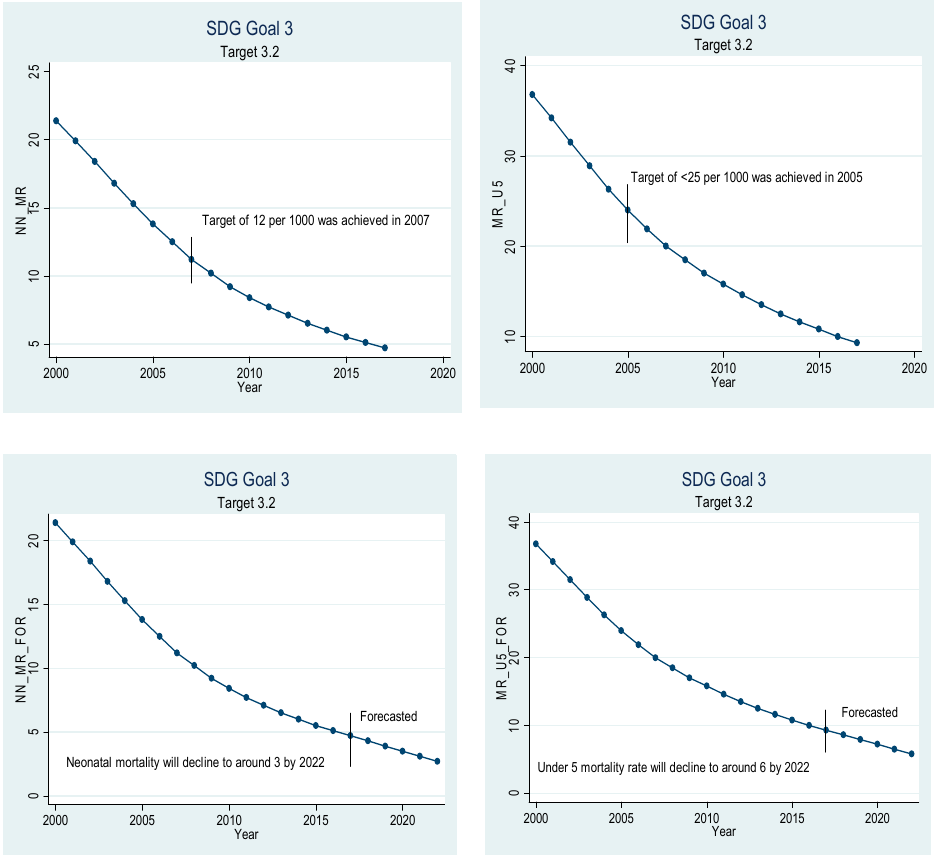
Figure 2. Sustainable development goal 3, target 3.2 (neonatal mortality) ex-post and ex-ante . Figure 3 is about target 3.3, which states that the countries should end epidemics such as tuberculosis, malaria, and neglected tropical diseases by the year 2030. China has al- most succeeded in eliminating malaria and tuberculosis. The incidence of malaria was recorded to be 0.000 patients per 1000 in 2017, and the incidence of tuberculosis was rec- orded to be only 63 per 100,000 population in 2017. If the current trend continues, malaria will be eliminated by 2022, and only 58 people out of 100,000 are expected to have TB in 2022. The results related to the incidence of tuberculosis seem to contradict the findings of [36] but it is not so. Our findings suggest that tuberculosis will still exist in the future and its incidence rate will be 0.058%, which is low enough to be neglected. The difference between our study and theirs is that their study only focuses on tuberculosis but ours is broader in context as we have studied the healthcare sector as a whole and not only a single disease. Figure 4 is related to target 3.4, which aims to lower mortality from non-communica- ble diseases through prevention and treatment. More and more patients are dying of non- communicable diseases rather than communicable diseases. In 2017, 89.6% of deaths were caused by non-communicable diseases, and only 10.4 deaths were caused by communica-